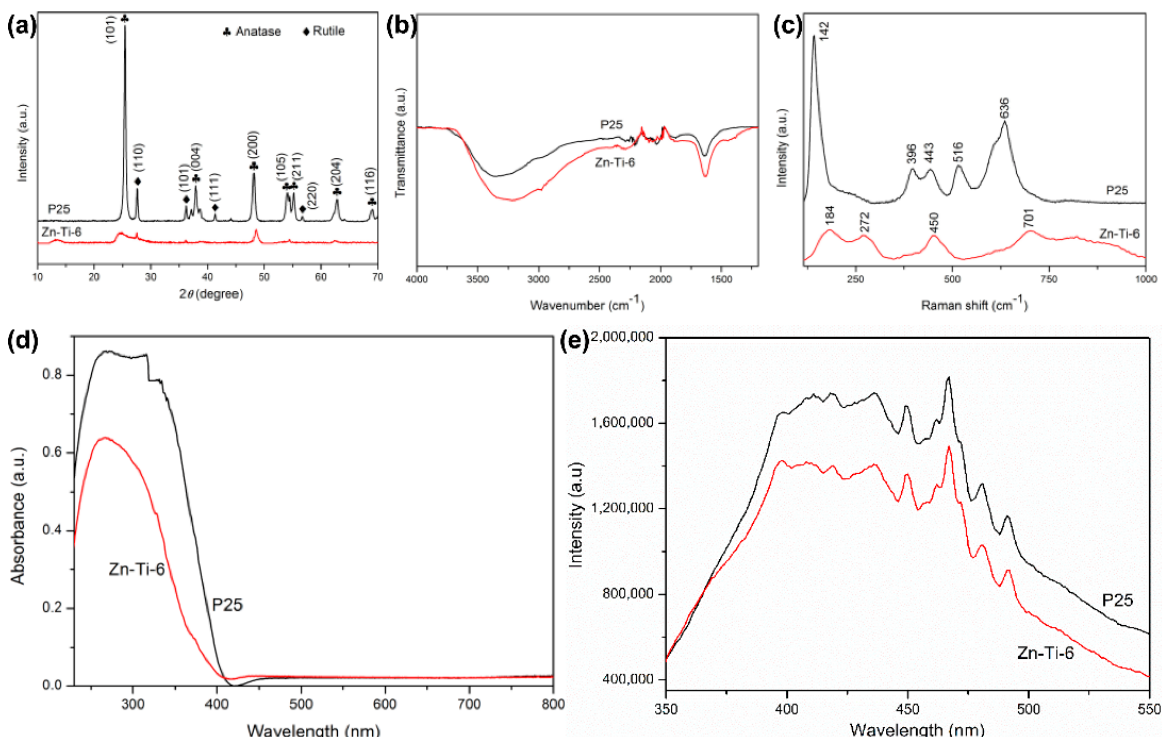
Figure 3. Optical properties: ( a ) XRD, ( b ) FTIR, ( c ) Raman, ( d ) UV-Vis diffuse reflectance spectra, and ( e ) photoluminescence spectra of P25 and Zn-Ti-6.